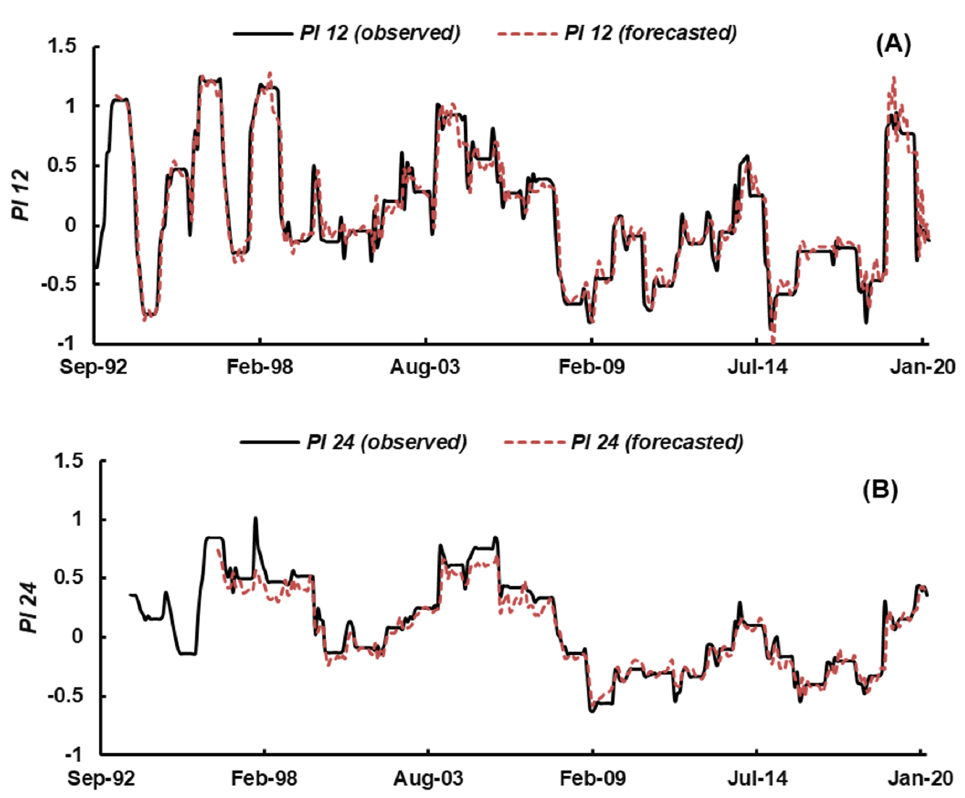
Figure 7. Observed and forecasted PI time series for the ( A ) 12-month and ( B ) 24-month drought forecast models.